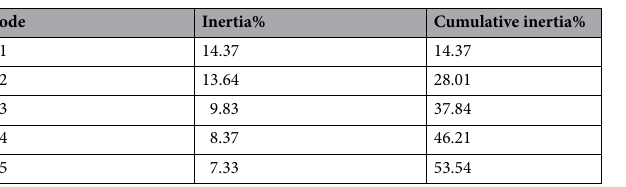
Table 3. Shape modes (M) with individual and cumulative contribution in LV variation (“Inertia %”). This represents the % shape variability captured by each shape mode individually and cumulatively.